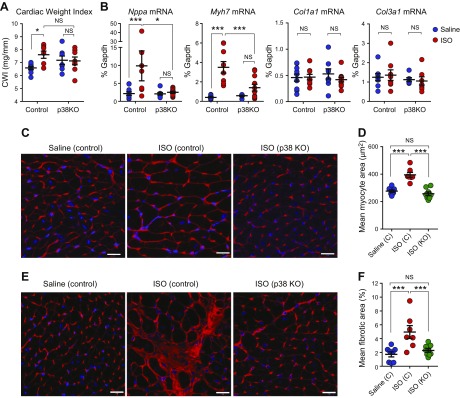
Effect of fibroblast-specific p38α KO on isoproterenol-induced cardiac hypertrophy. Control or Fb-p38α KO mice were injected with tamoxifen and mini-osmotic pumps implanted for delivery of saline or ISO as in Fig. 2A. Pumps were removed and heart tissue collected 1 wk later. A) Ventricular weight/tibia length ratio (cardiac weight index) from animals used in PV analysis. Group sizes: control saline (n = 9), control ISO (n = 8), KO saline (n = 7), and KO ISO (n = 8). B) Real-time RT-PCR analysis of cardiac mRNA levels for cardiomyocyte hypertrophy markers atrial natriuretic factor (Nppa) and β-myosin heavy chain (Myh7) and fibrosis markers Col1a1 and Col3a1. Group sizes: control saline (n = 11), control ISO (n = 9), KO saline (n = 8), and KO ISO (n = 11). C) Representative images of WGA-labeled heart sections used to determine myocyte cross-sectional area. D) Mean cardiomyocyte size (cross-sectional area) determined from WGA-stained images. Group sizes: control saline (n = 8), control ISO (n = 7), and KO ISO (n = 8). E) Representative images of WGA-labeled heart sections used to determine areas of interstitial fibrosis. F) Mean interstitial fibrotic area determined from WGA-stained images. Group sizes: control saline (n = 8), control ISO (n = 7), and KO ISO (n = 8). NS, not significant. Scale bars, 20 μm. Individual data and means ± sem are shown. *P < 0.05, **P < 0.01, ***P < 0.001 (ANOVA with Šidák post hoc test).